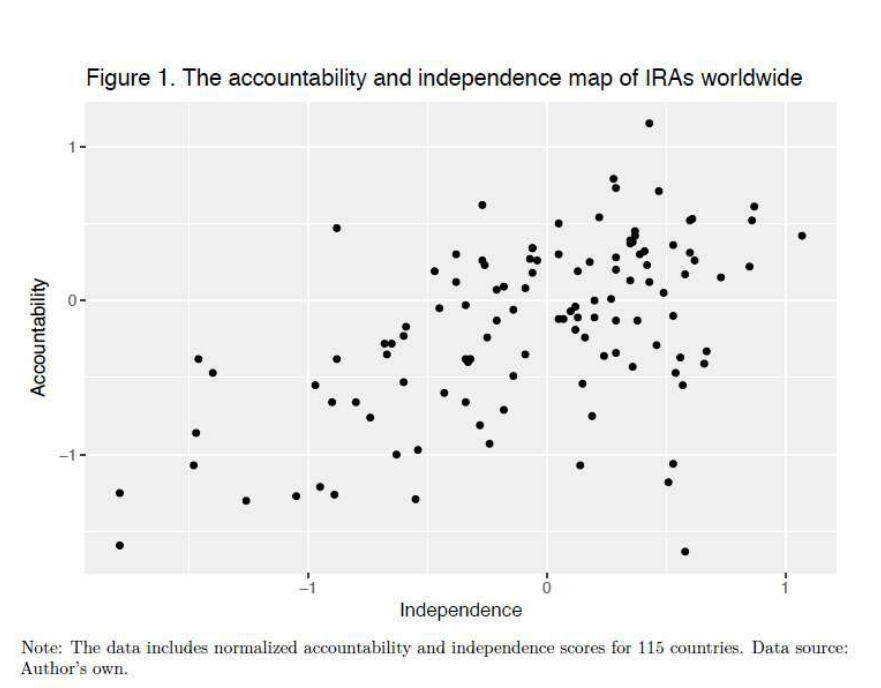
Figure 1. The accountability and independence map of IRAs